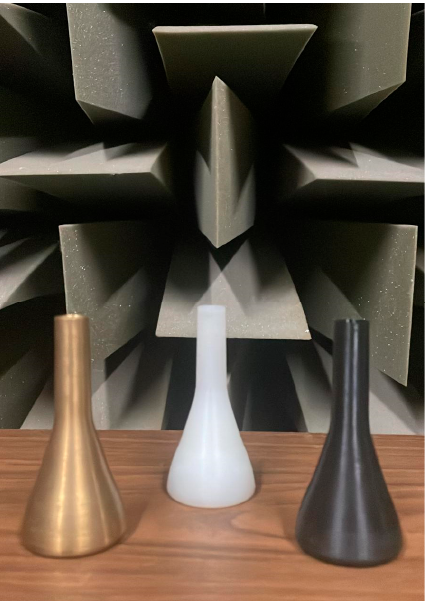
Figure 7. Manufactured mouthpieces in the anechoic chamber of the Higher Polytechnic School of Gandia. Materials, from left to right: brass, nylon and PLA.